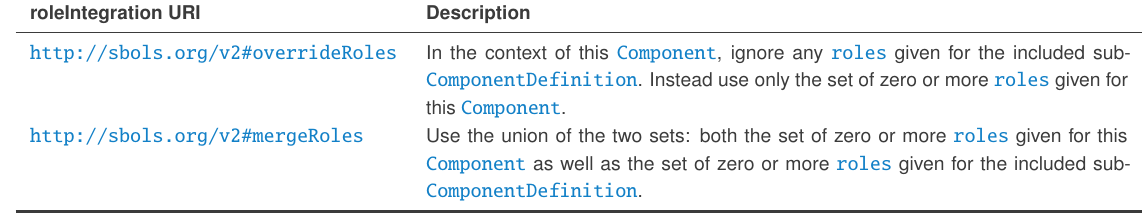
Table 6: Each roleIntegration mode is associated with a rule governing how a Component ’s roles are to be combined with the included sub- ComponentDefinition ’s roles.